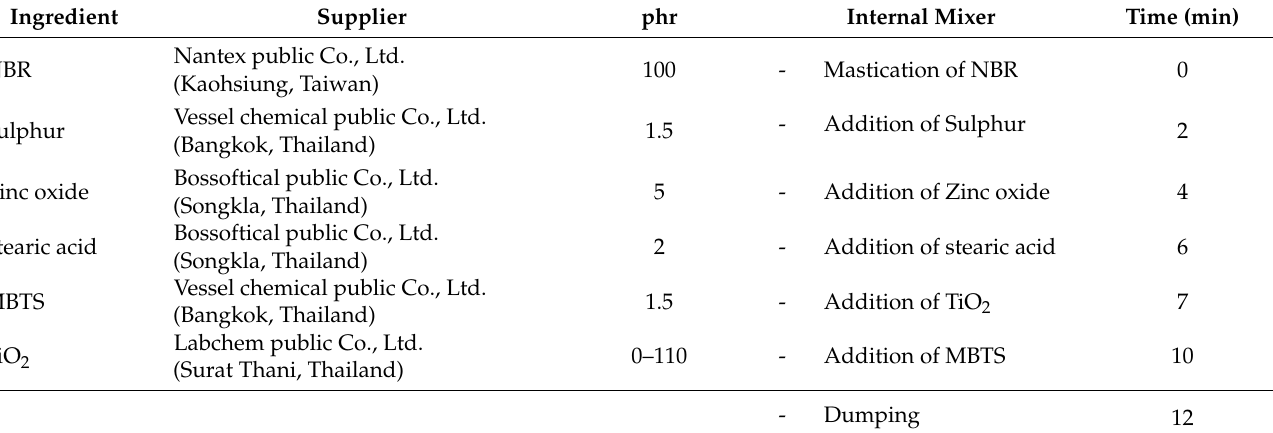
Table 1. Details of the materials and compounding formulations of TiO 2 -filled NBR